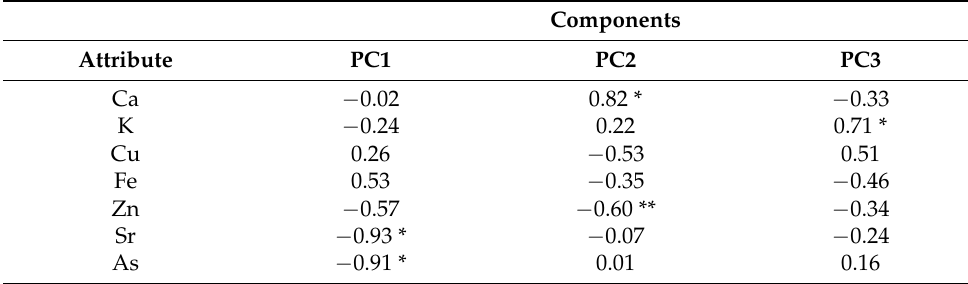
Table 5. Correlation coefficients between attributes (initial variables) and PC1 and